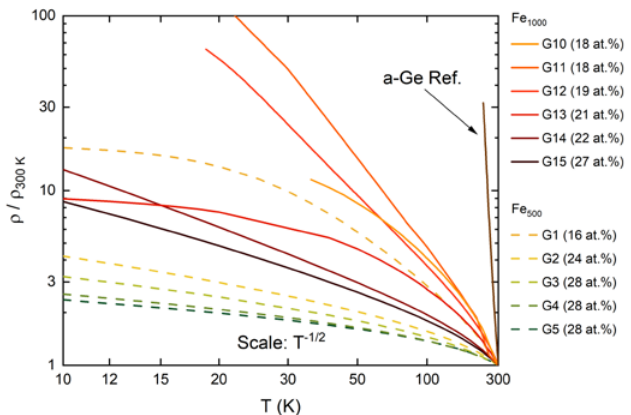
Figure 13. Log-scaled relative resistivity RR vs. temperature scaled as T − 1/2 . Straight line appearance in this scaling is characteristic for tunneling between isolated metallic grains (see text). RR increases slower with decreasing temperature for samples with a smaller amount of Fe clusters embedded. RR is generally smaller for samples containing the smaller clusters.